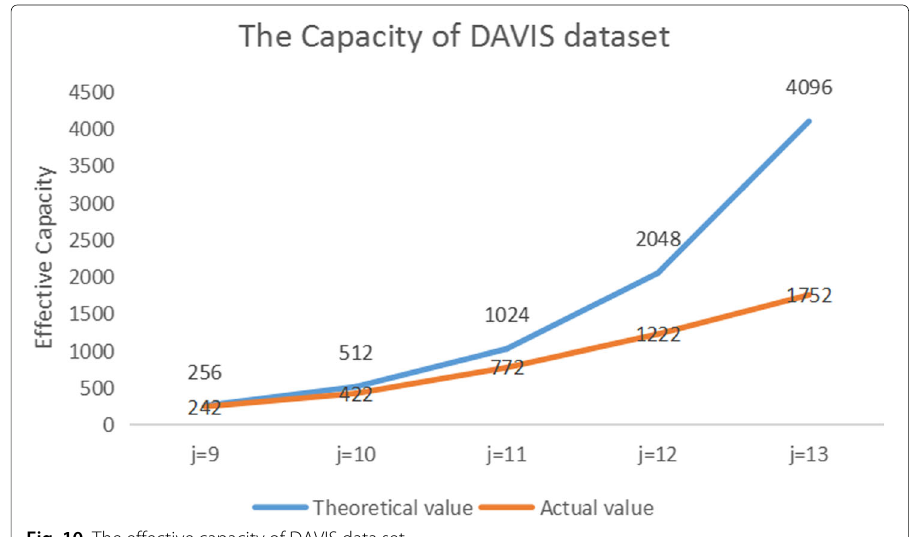
Fig. 10 The effective capacity of DAVIS data set